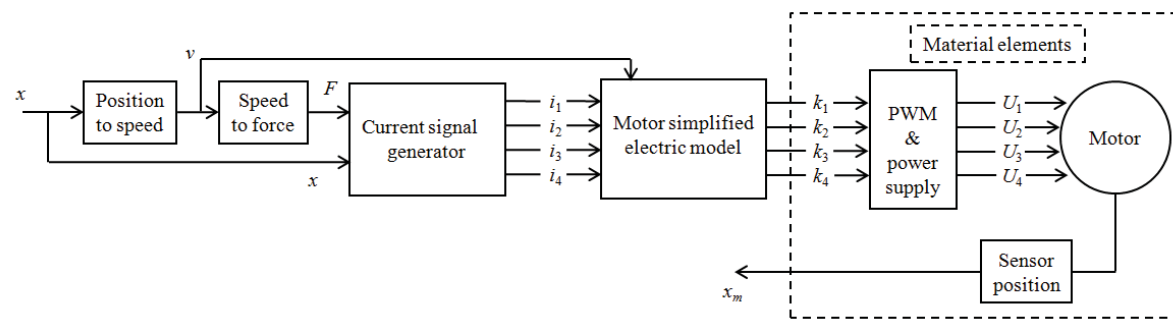
Figure 5. Open loop control of the motor. PWM, pulse-width